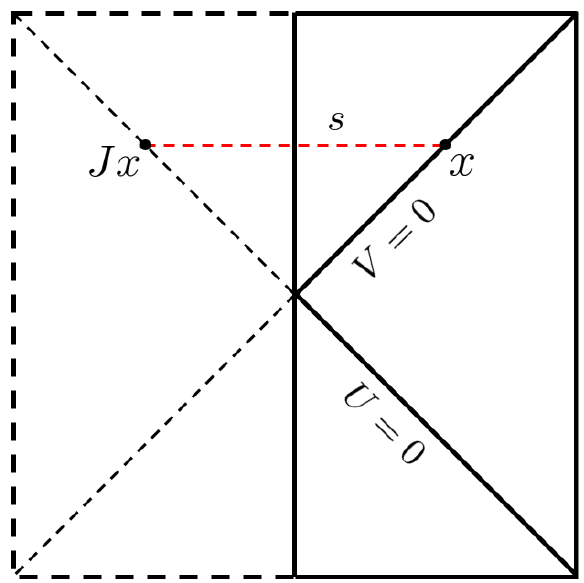
Figure 1 . Conformal diagram of the R P 2 geon, KKEOW, and KKZBO geometries, with null coordinates ( U; V ) indicated. The left region (dashed lines) is the image of the right (solid lines) under the Z 2 isometry J which exchanges U $ V , so that the right alone may be used to represent the quotient. The desired isometries J also act on S 1 factors (just S 1 for the R P 2 geon and S 1 (cid:2) S 1 for the KKEOW and KKZBO geometries) not shown in the (cid:12)gure. The geodesic proper distance s between a point x on the horizon and its image Jx is non-zero and spacelike in all cases, though for U = V = 0 this is a result of the additional action of J on suppressed angles (cid:30) and/or (cid:18) not shown in this